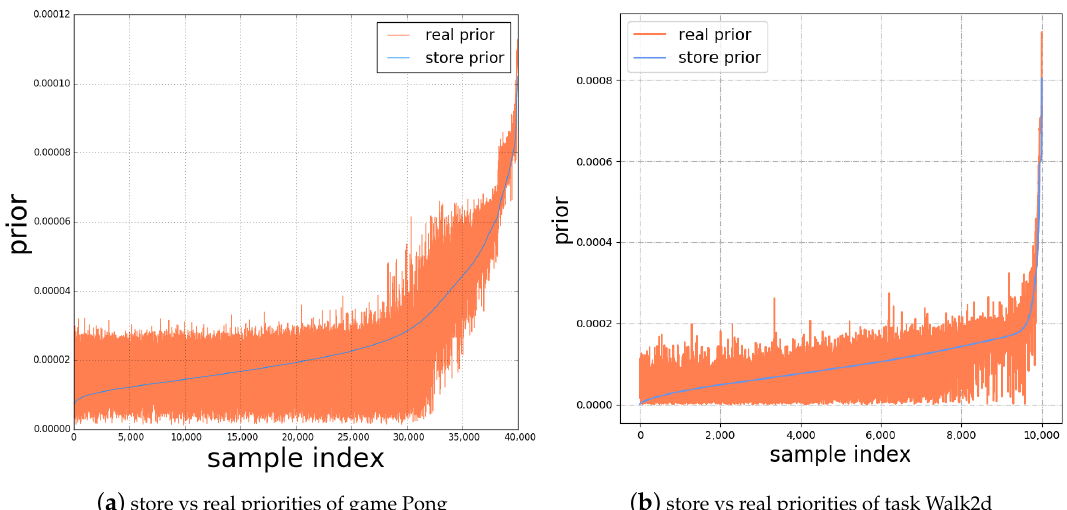
Figure 1. The similarity of distributions of real and stored priorities in Atari game Pong and MuJoCo walk2d. The x-axis is the index of the sample, which is sorted according to the stored